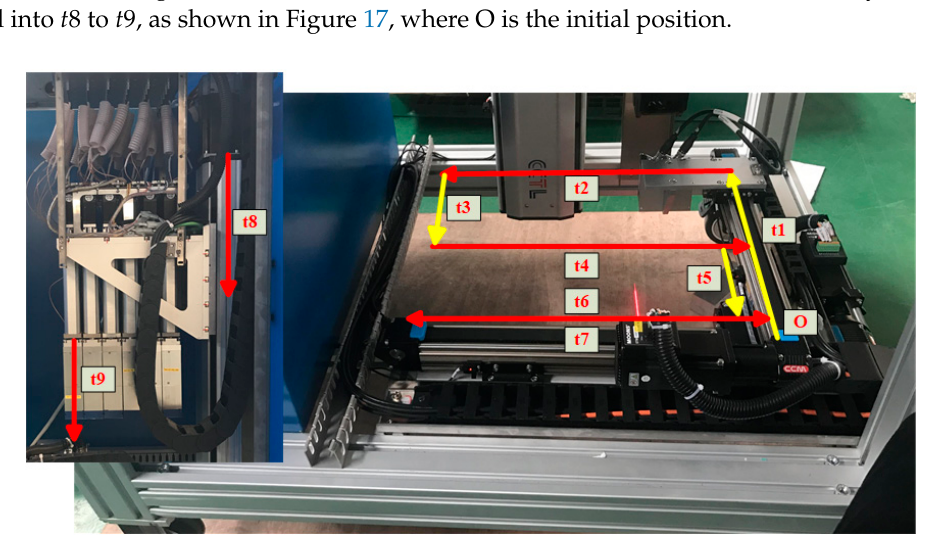
Figure 17. Schematic diagram of movement path of the X -axis and Y -axis motion platform.